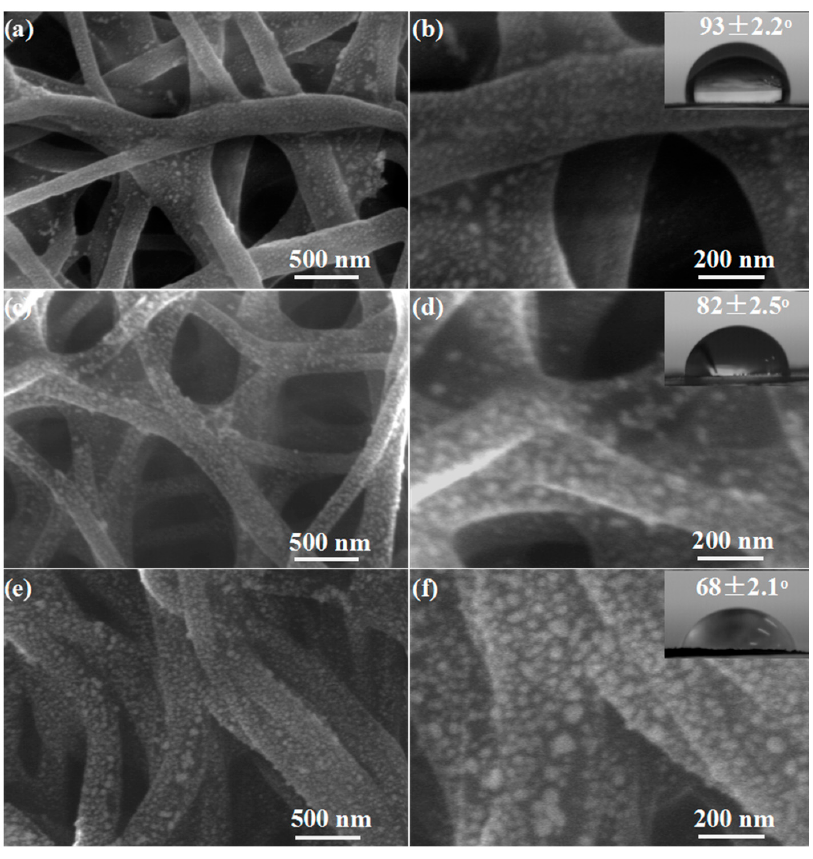
Figure 2. SEM images with different magnification of ( a , b ) PU-1, ( c , d ) PU-2, and ( e , f ) PU-3 nanofibrous membrane, the insets in ( b , d , f ) show images of water drops and the corresponding contact angles.